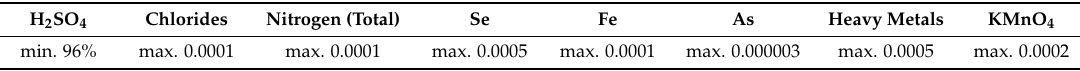
Table 2. The composition of the H 2 SO 4 solution/weight percentage of the additive elements (%).